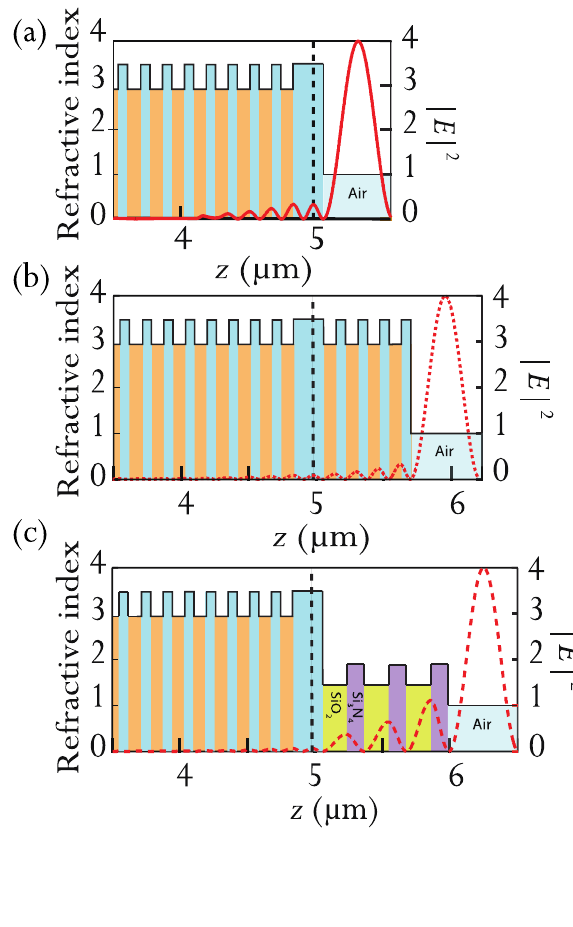
Figure 7. Different SESAM structures used for the damage studies ( a ) SESAM design with 3 QWs and no topcoating (NTC); ( b ) same SESAM but with a 4-quarter-wave-pair GaAs/AlAs semiconductor topcoating (SCTC); ( c ) same SESAM but with a 3-quarter-wave /Si N dielectric topcoating (DTC3); ( d ) field enhancement in the absorber pair SiO 2 3 4